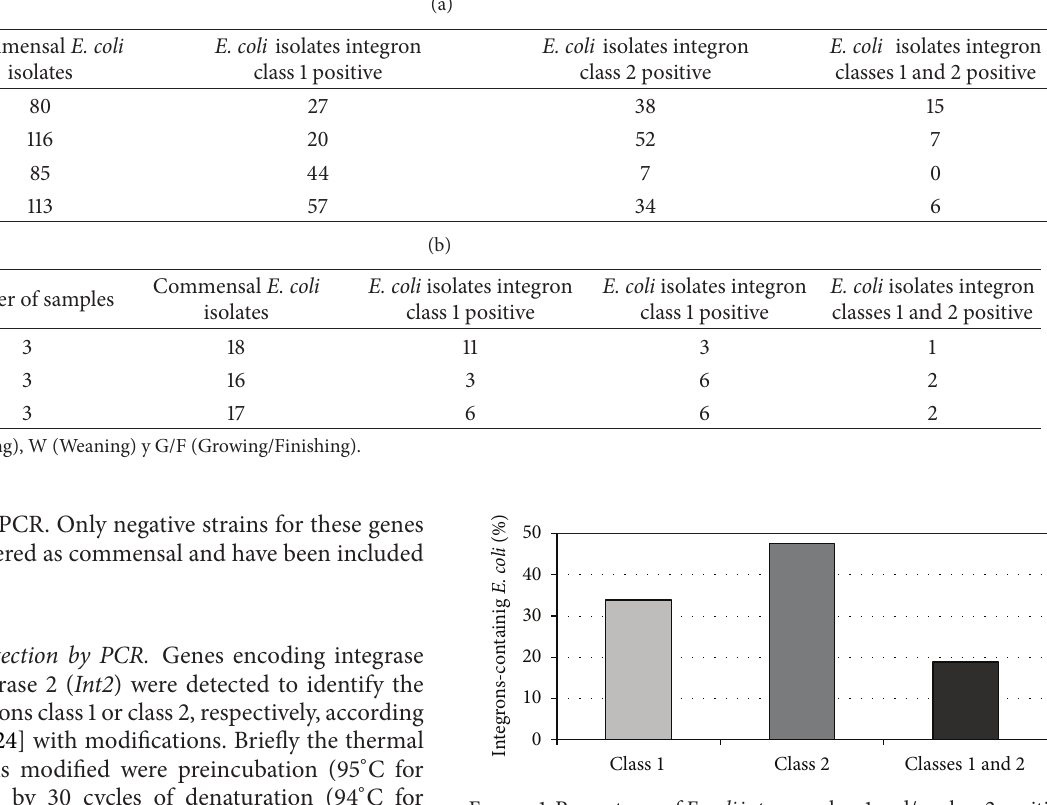
Figure1:Percentagesof E.coli integronclass1and/orclass2positive isolates in